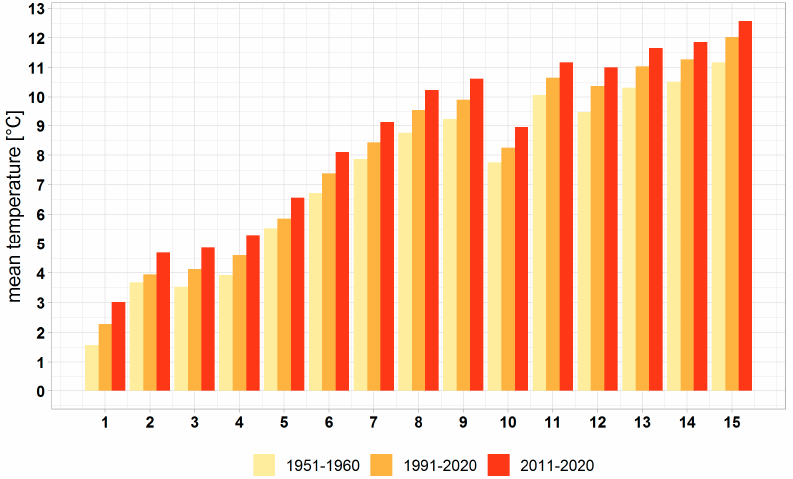
Figure 8. The variation of mean annual temperature over the analyzed period for the main forest types.